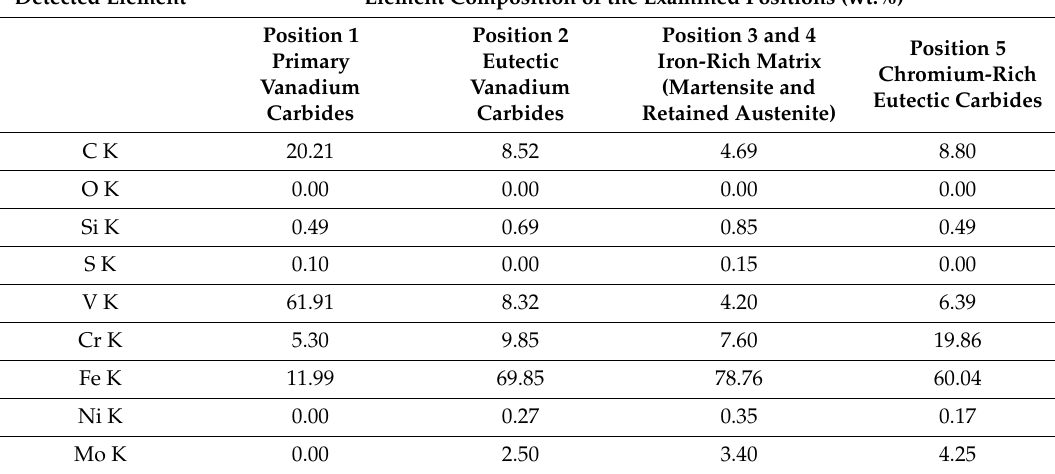
Table 2. Electron dispersive X-ray analysis (EDX) measurements of the examined positions illustrated in Figure